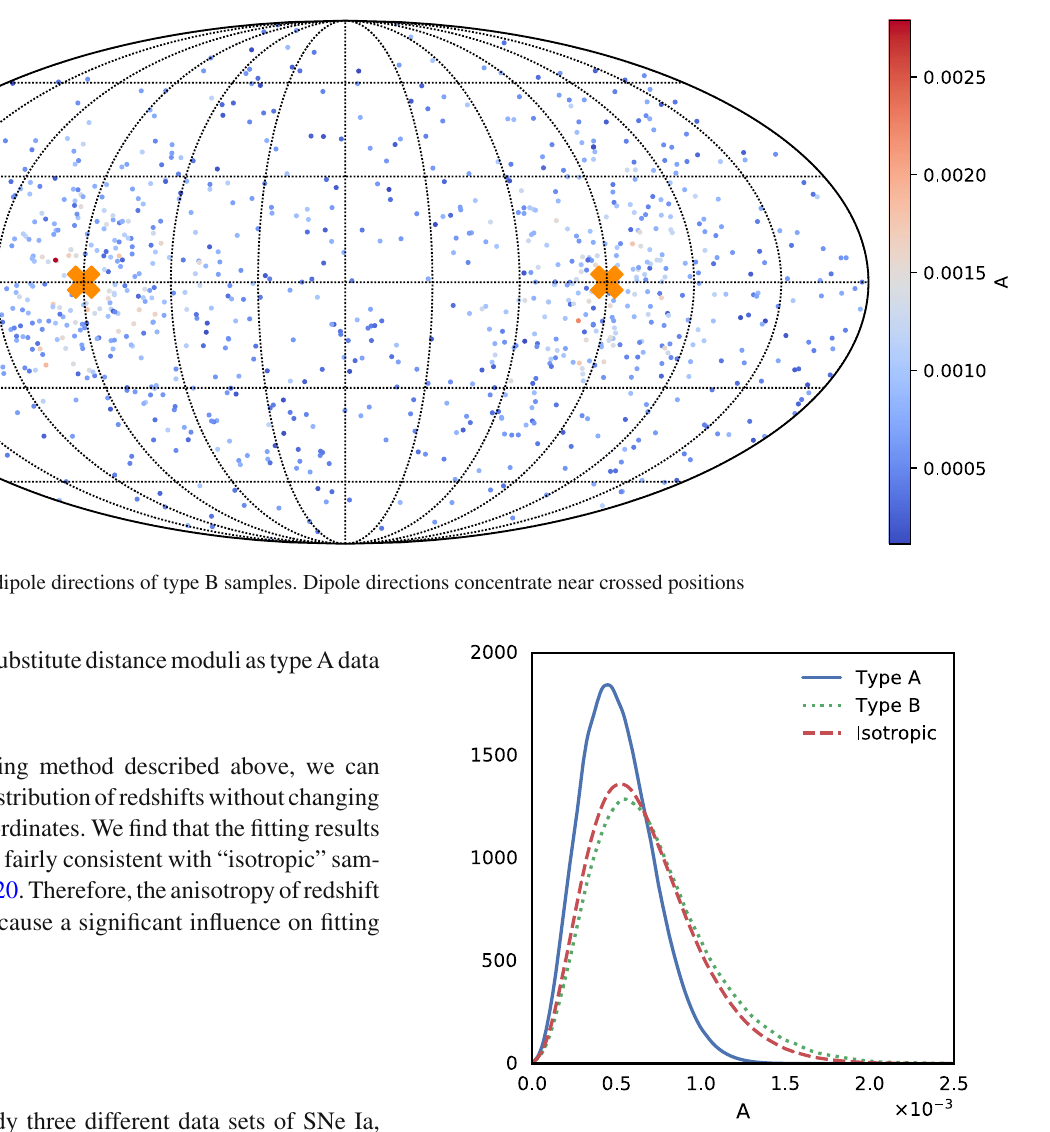
Fig. 17 Likelihood of dipole magnitude A of different samples. Blue solidlineindicatestheresultofsyntheticsampleswithisotropicallydis- tributed coordinates, which tend to reduce the dipole magnitude. Green dotted line indicates the result of synthetic samples with extremely an- isotropically distributed coordinates, which increase the dipole magni- tude